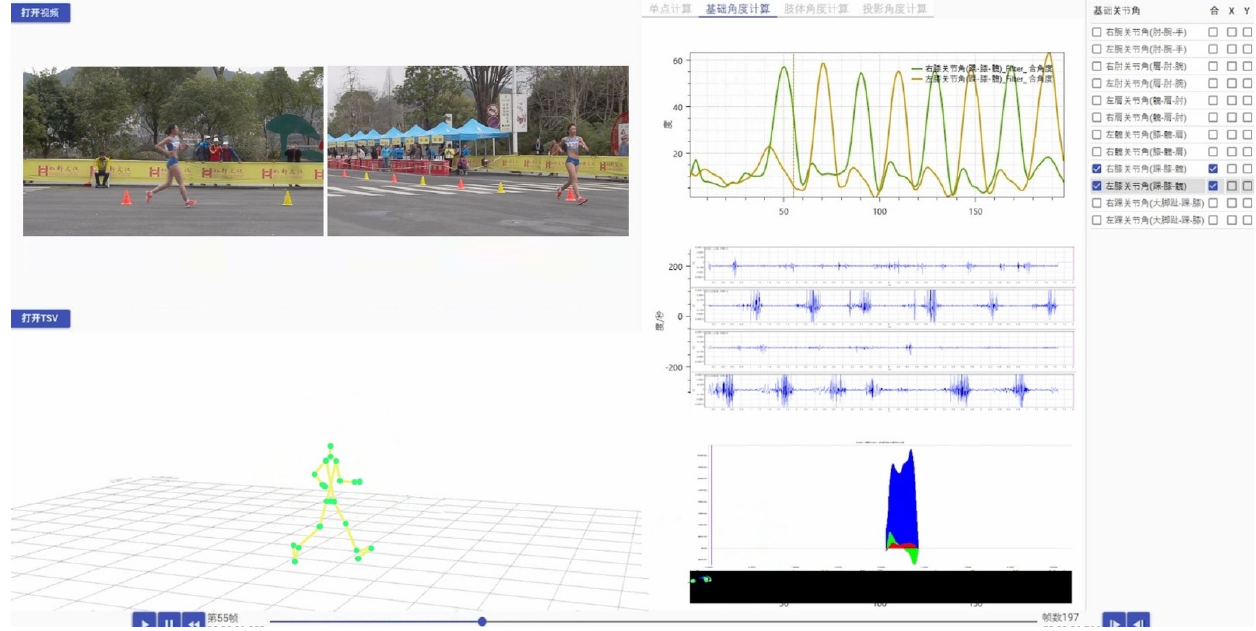
Figure 1. Data processing interface of artificial intelligence 3D motion analysis system.